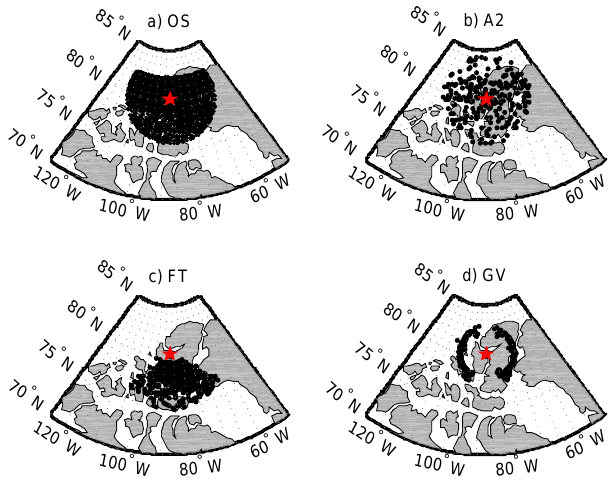
Fig. 2. Location of ozone air mass sampled by (a) all OSIRIS scans and (b) ACE-FTS v2.2 occultations used in this study; and (c) Bruker FTIR and (d) GBS spring-time measurements. PEARL is indicated by the red star. Locations of the OSIRIS scans are shown for the 25-km air mass, while all other measurements are shown for the 30-km air